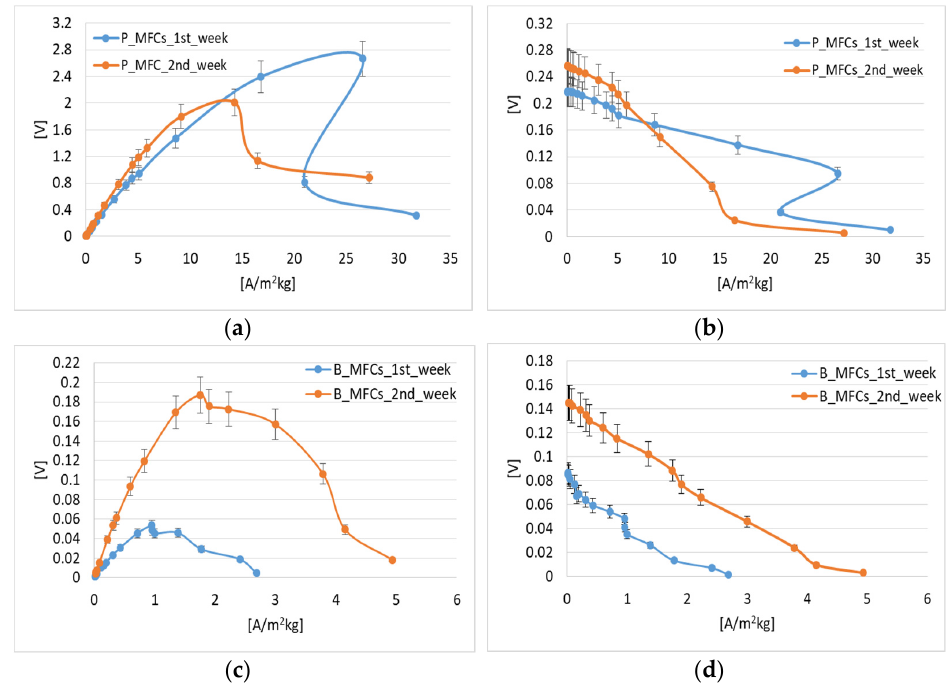
Figure 7. P_MFCs ( a , b ) and B-MFC ( c , d ) power and polarization curves. The diagrams report voltage, current and power densities average values 𝑆𝐸 over three independent experiments.